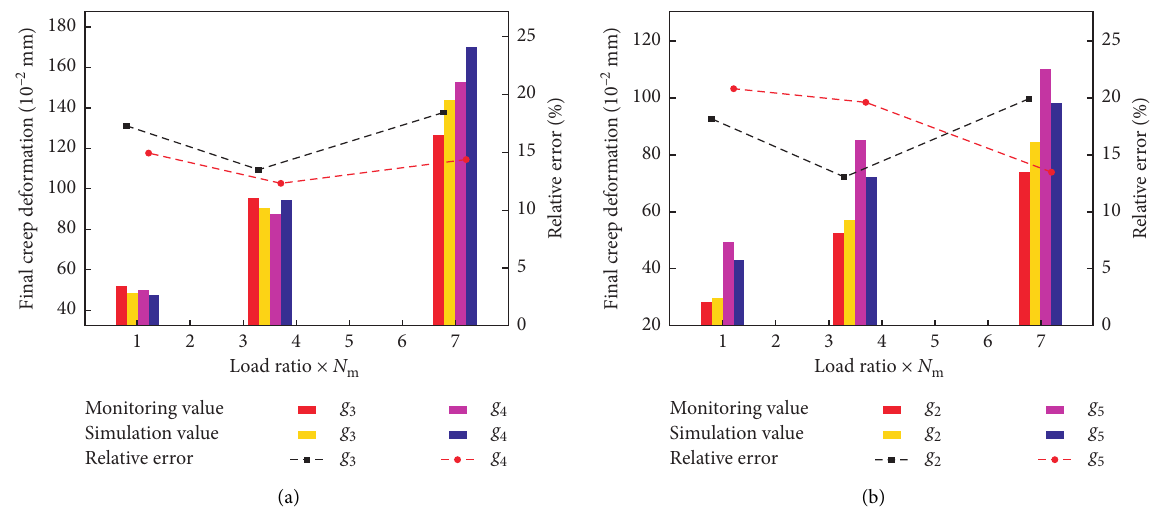
Figure 24: Comparison between experiment measurements and simulation results of (a) tunnel anchor and (b) surrounding rocks.